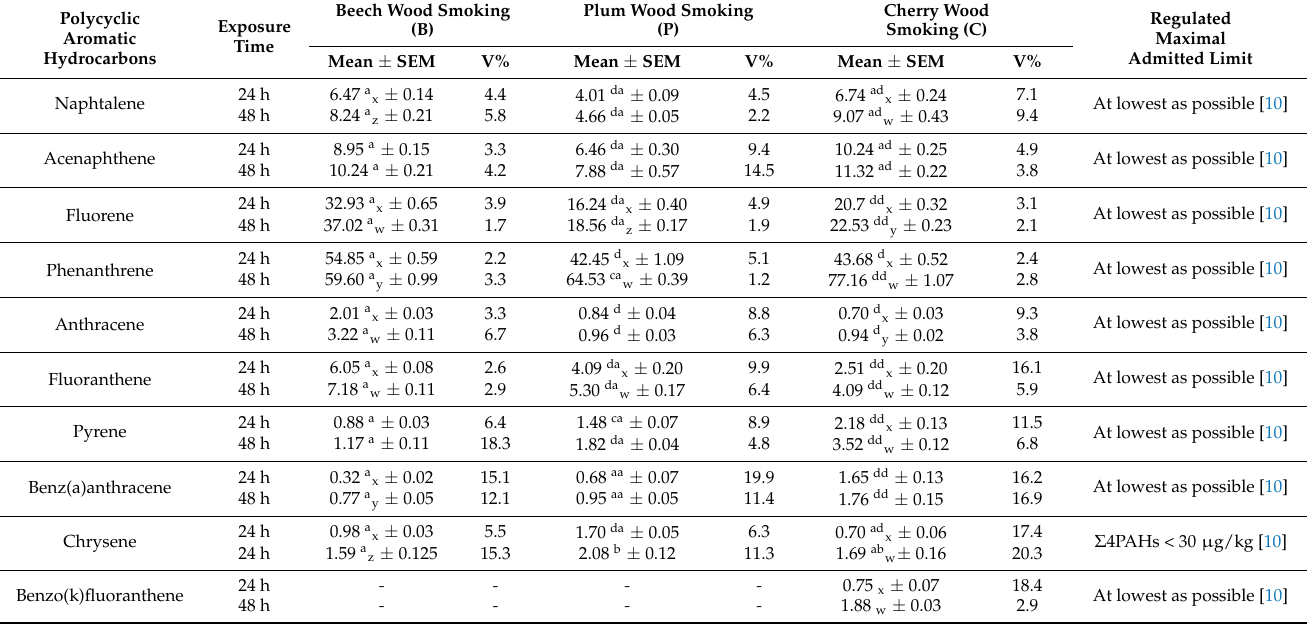
Table 2. Variance of total PAHs accumulation in chicken meat ( µ g PAH/kg meat, ppm).